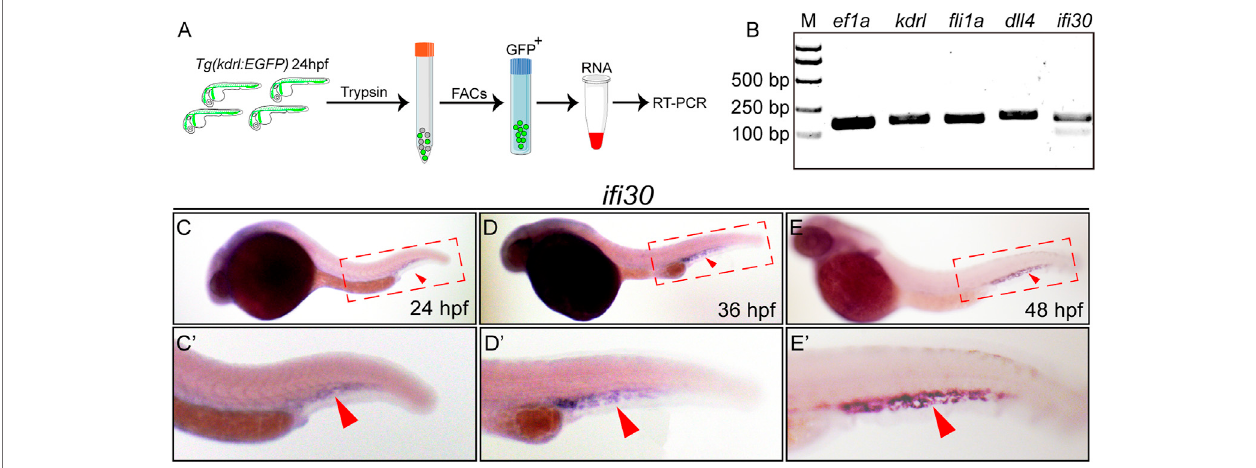
FIGURE 1 | i fi 30 enriches in endothelial cells (ECs) and expresses in caudal vein plexus (CVP) region (A) Schematic representation of isolation of ECs from Tg(kdrl: EGFP) zebra fi shembryosforRNAextractionandRT-PCR (B) Expressionsof kdrl , fl i1a , dll4 ,and i fi 30 inECsareexaminedbyRT-PCR. ef1a isusedasthehousekeeping gene. M indicates the DNA ladder and the corresponding sizes are marked on the left (C – E) Expression of i fi 30 in zebra fi sh embryos from 24 to 48 hpf (C 9 -E 9 ) Magni fi cations of the red dotted boxes in the corresponding (C) (D) , and (E) panel, respectively. I fi 30 is specially expressed in the CVP region (indicated with red